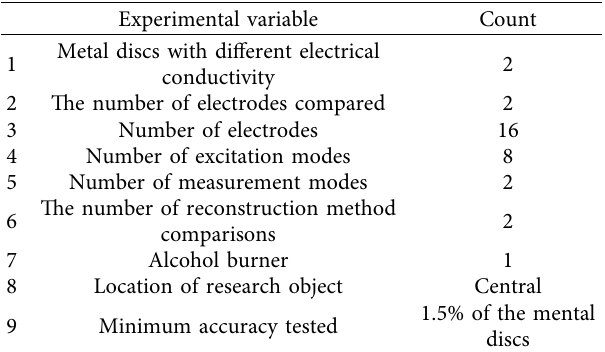
Figure 7: Finite element model meshing diagram. Table 1: Experimental summary table. Table 2: Experimental material size